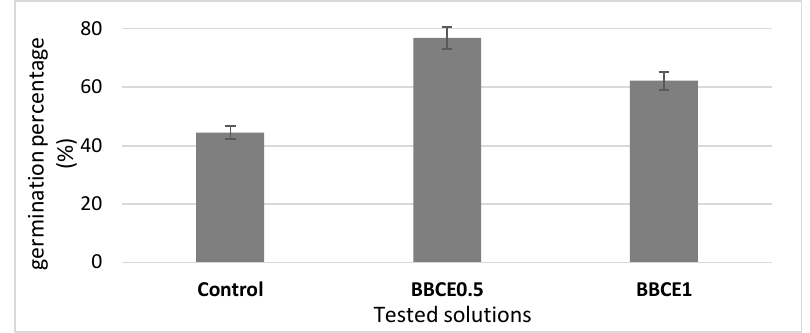
Figure 1. The influence of beech ( Fagus sylvatica L.) bark crude extract (BBCE) on Salvia officinalis L. seed germination capacity. Error bars represent the standard deviations of means. BBCE0.5 — beech bark crude extract 0.5 g bark/100 mL extract; BBCE1 — beech bark crude extract 1 g bark/100 mL extract.